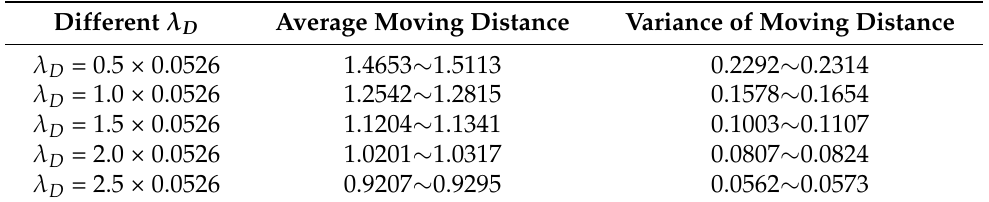
Table 2. The ranges of average moving distances and their variances corresponding to different λ D values.